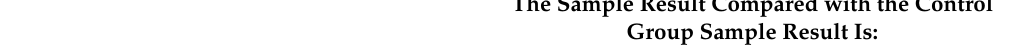
Table 5. Simplified interpretation of the proteolytic system activity results from the honey bee hemolymph solutions during contact with unfavorable/harmful factors. The Sample Result Compared with the Control Group Sample Result Is: Increased Decreased acidic + “+” only on the first of the Protease activity neutral + three days, and “ − “ later on alkaline Protease inhibitor